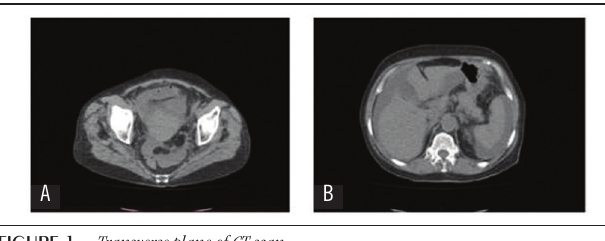
figurE 1 − Transverse plane of CT scan A) showing the uterus distended with significantly fluid-filled uterus; B) presence of fluid within the abdominal cavity. CT: computed tomography.